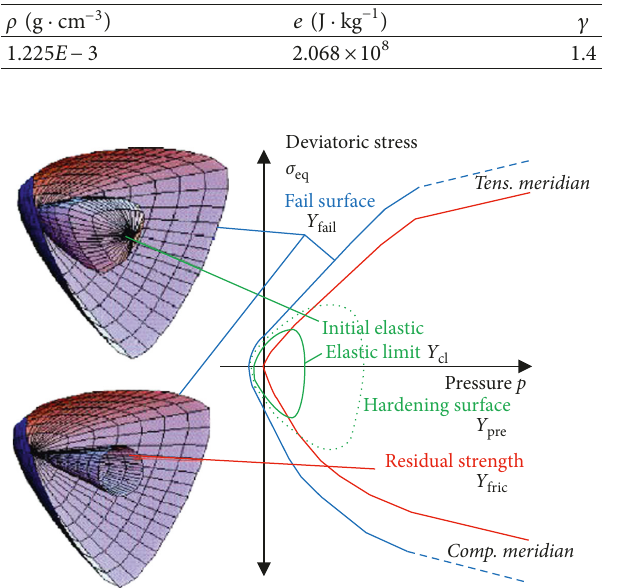
Table 1: Material parameters of air.